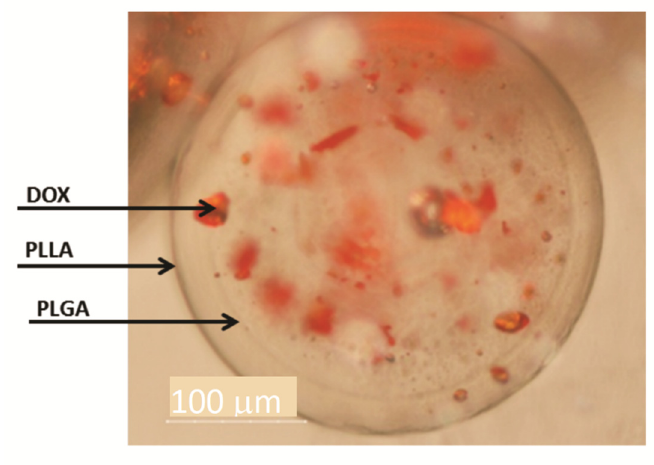
Figure 4. Optical microscopy of DWMP of PLLA/PLGA 2:1. The arrows indicate the outer surface, the interface between PLLA and PLGA and the interface between PLLA and PLGA and DOX.